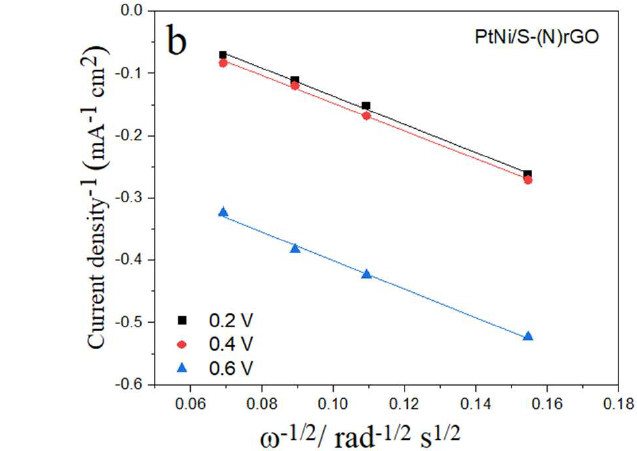
Figure 7. Changes of ECSA of three catalysts with different cycles under the same electrochemical acceleration test. Figure 8 shows the polarization and power density of PtNi/S-(N)rGO and commer- cial Pt/C as the cathode, with commercial Pt/C as the anode for testing in single fuel cell. The polarization curves of PEMFC were divided into three parts corresponding to three stages of polarization, which were electrochemical, ohmic, and concentration polarization,